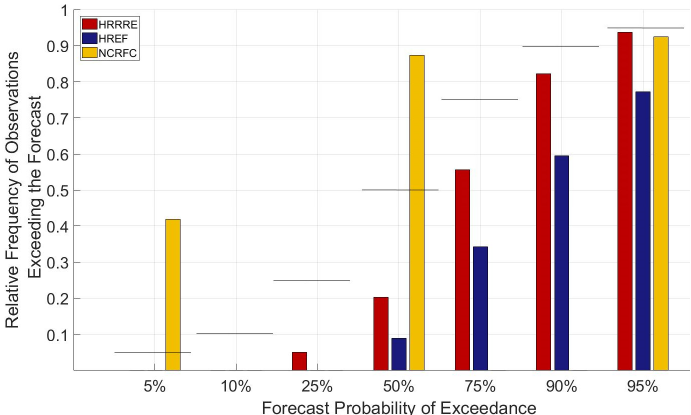
Figure 5. Relative frequency of observations exceeding the forecasts for different forecast probability of exceedance values. All datasets use the same 79 events that are common between the NCRFC and PQPF datasets.